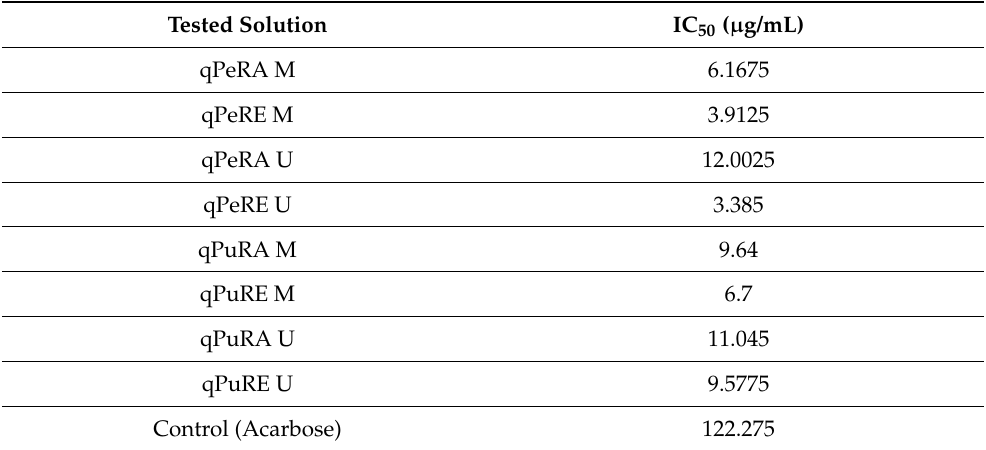
Table 4. IC 50 values for the tested solutions against α